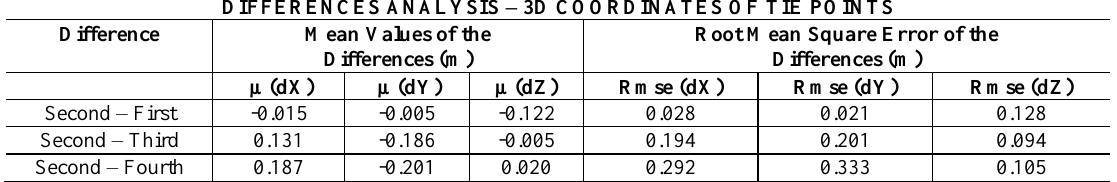
Table 6. Main results of the analysis of differences of tie points coordinates performed in the in situ self-calibration experiments